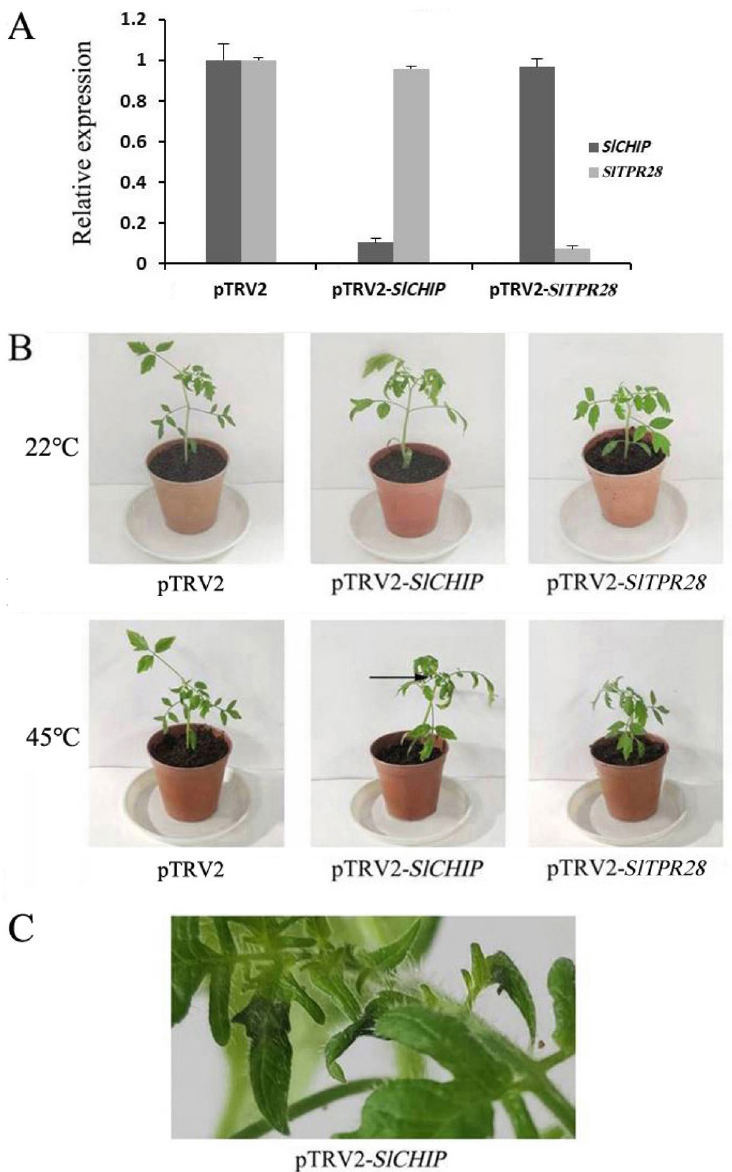
Figure 4. Phenotypic analysis of SlCHIP - or SlTPR28 -silenced plants after heat stress. ( A ) SlCHIP and SlTPR28 transcript levels in SlCHIP - and SlTPR28 -silenced tomato lines. The terminal leaflets in the fifth leaves of 20 individual 6-week-old plants were collected for RNA extraction and RT-qPCR analysis. Means of transcript levels were calculated from 12 plants with > 80% silencing efficiency and shown with SE (n = 12). These plants were used in the subsequent assays of heat tolerance. ( B ) Heat stress symptoms of SlCHIP- or SlTPR28- silenced plants. Six-weeks old mock (pTRV2), SlCHIP- silenced (pTRV2- SlCHIP ) and SlTPR28- silenced (pTRV2- SlTPR28 ) plants were placed in a 45 °C growth chamber for 9 h. The picture was taken after 9 h heat treatment. ( C ) Water soaking symptom on leaflets of the fourth leaves in SlCHIP- silenced plants. Experiments were repeated three times with similar